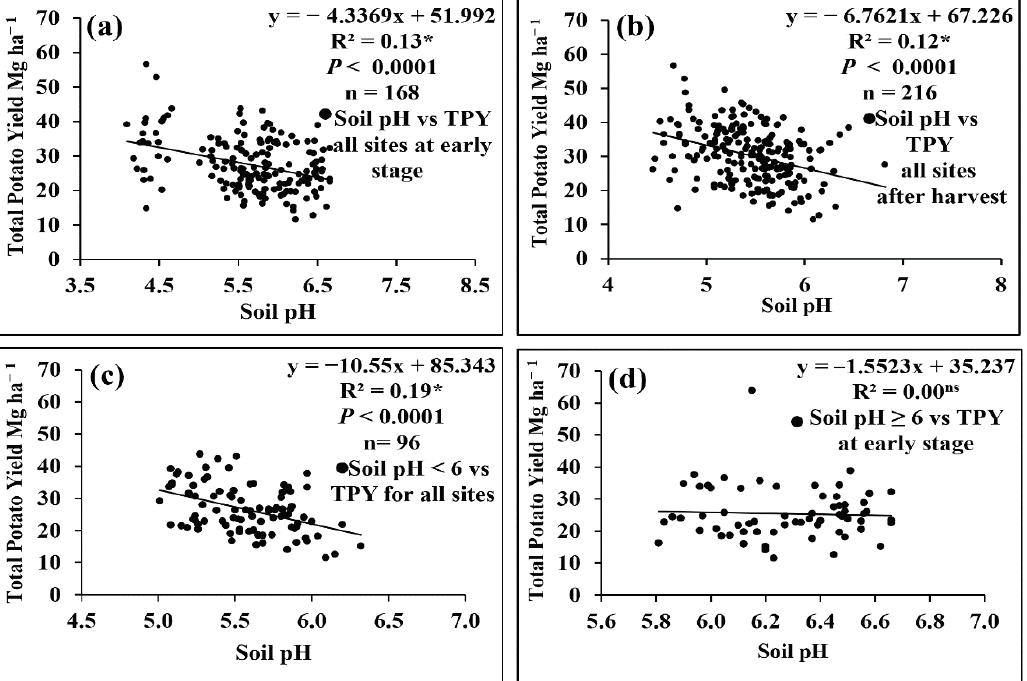
Figure 3. Relationships between soil pH and total potato yield ( a ) all sites at the early potato stage for 2018 and 2019 ( b ) all sites after harvest for years 2018 and 2019 ( c ) all sites (soil pH < 6) at potato harvest, ( d ) all sites (soil pH ≥ 6) at early potato stage. * Significantly different at P < 0.05. TPY: Total potato yield. ns: Nonsignificant.